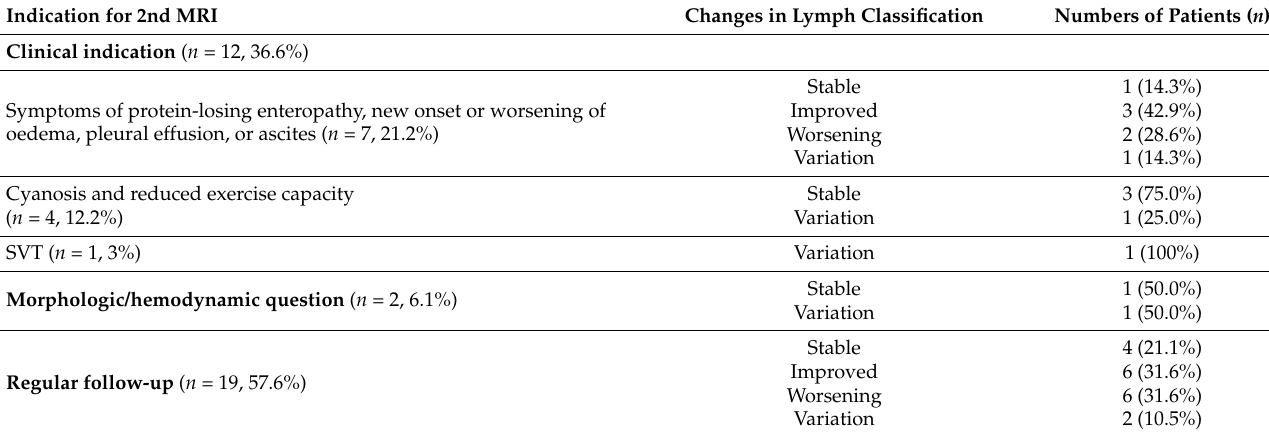
Table 2. Indication for follow-up MRI and clinical changes in lymphatic